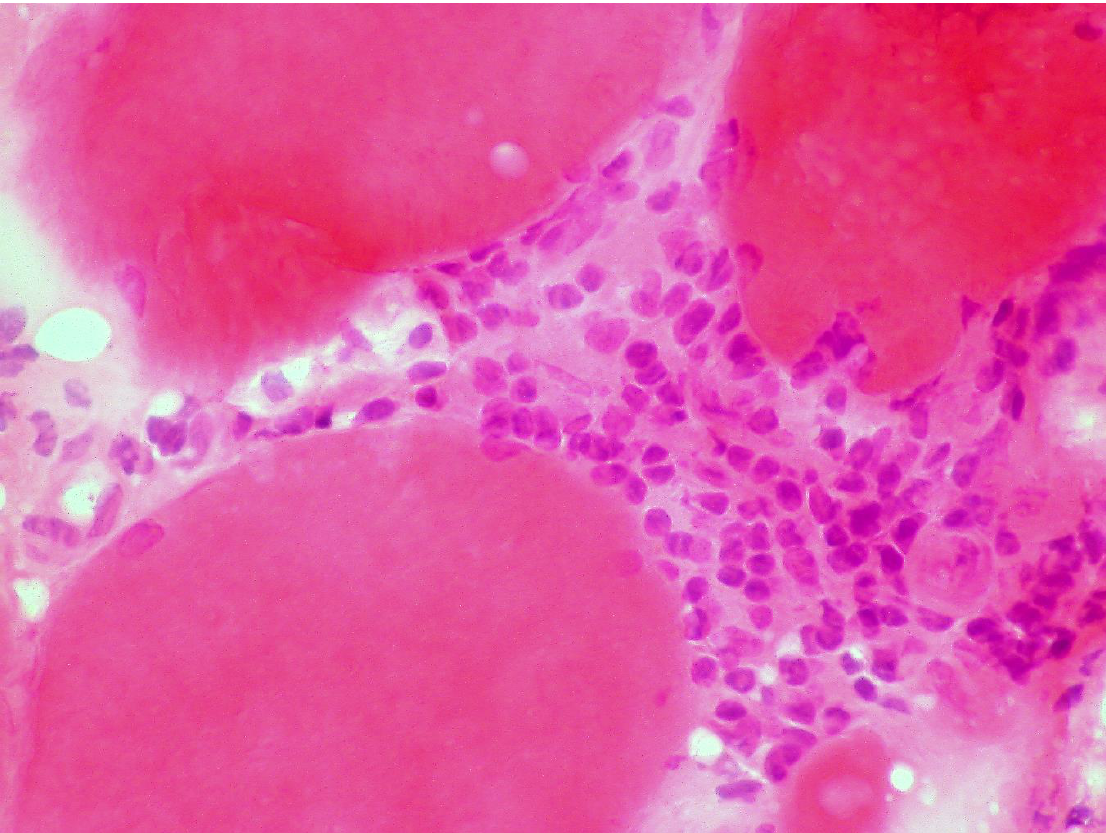
Figure 4. Skeletal muscle biopsy obtained from a patient with gluten myopathy showing myocytes surrounded by lymphocytic infiltration suggestive of an inflammatory process (H&E stain, magnification 400×).